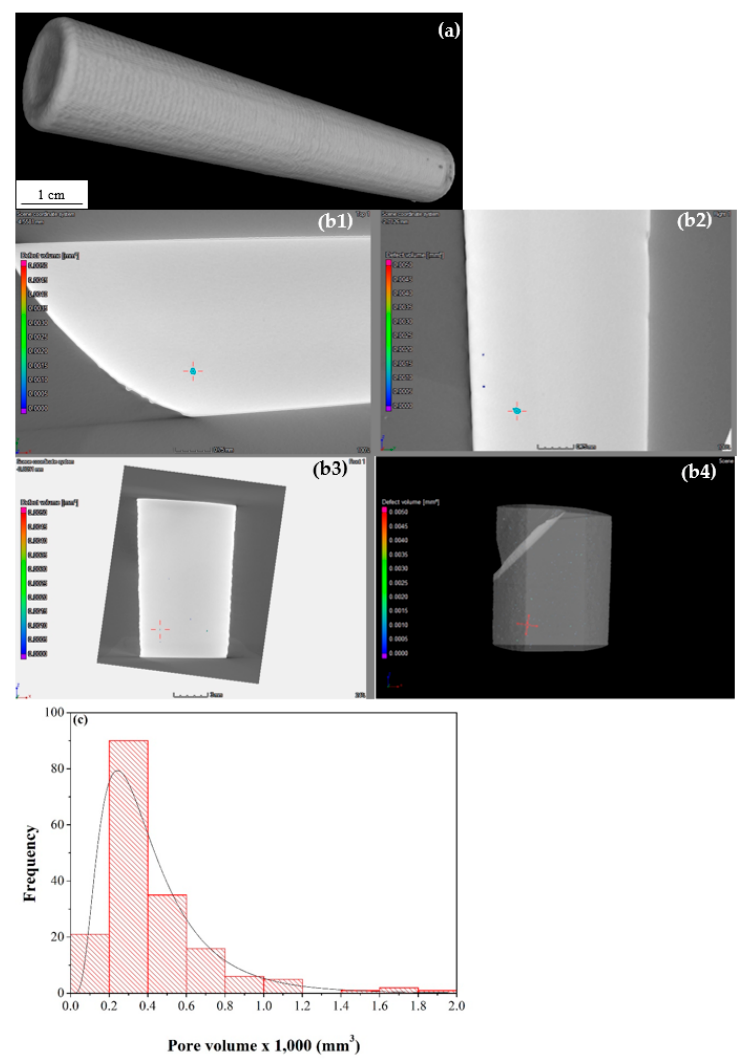
Figure 8. ( a ) µ -CT scan of the steel rod showing no evidence of porosity and other defects. ( b ) µ -CT scan of a cut piece at higher resolution revealing some small defects in the bulk material. ( b1 ) XY plane cross-section of the defect. ( b2 ) YZ plane cross-section of the defect. ( b3 ) XZ plane cross-section of the defect. ( b4 ) 3D model with a defect highlighted. ( c ) Pore size distribution in the stainless steel piece with lognormal distribution fit.